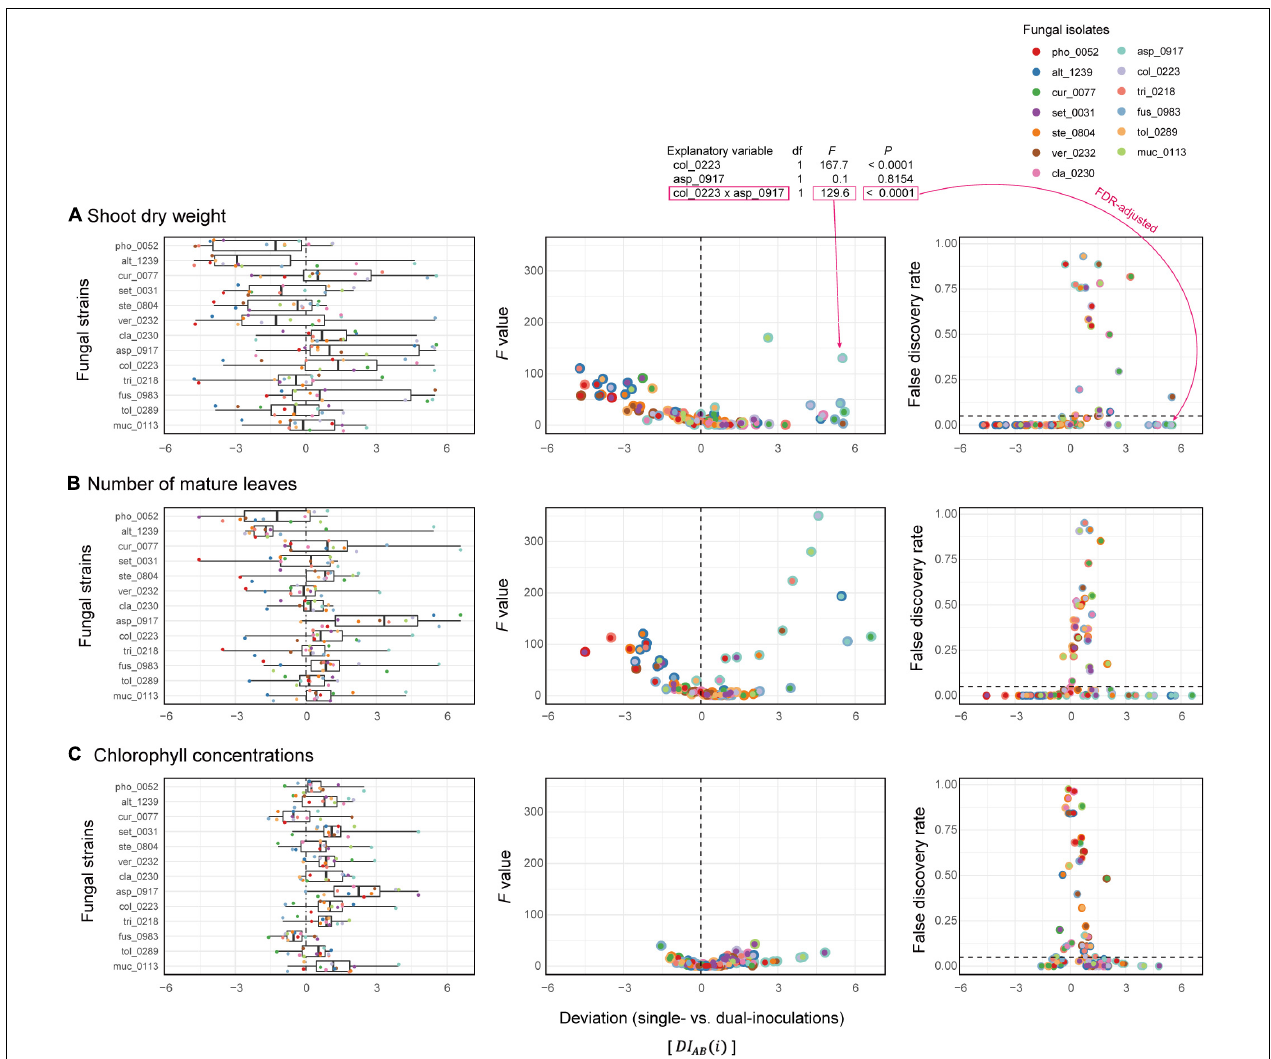
FIGURE 7 | Deviations of observed dual-inoculation results from those expected as intermediate results of single inoculations. (A) Deviation index for shoot dry weight. The index values representing deviations of dual-inoculation effects from intermediate effects in single inoculations ( DI AB ( i ) ) are shown for each fungal isolate included in the target fungal pairs (left). For each fungal pair, F values of the isolate A × isolate B term in the ANOVA model (middle) and false discovery rate (FDR) values of the interaction term (right) are shown across the axis of the deviation index: FDR are calculated across the 78 fungal combinations examined. (B) Deviation index for the number of mature leaves. (C) Deviation index for chlorophyll